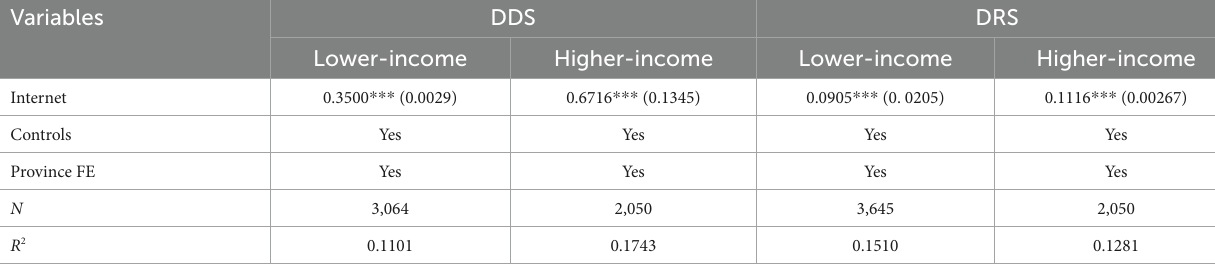
TABLE 8 Results of heterogeneity analysis on the relationship between the Internet and the incomes of farm households. Variables